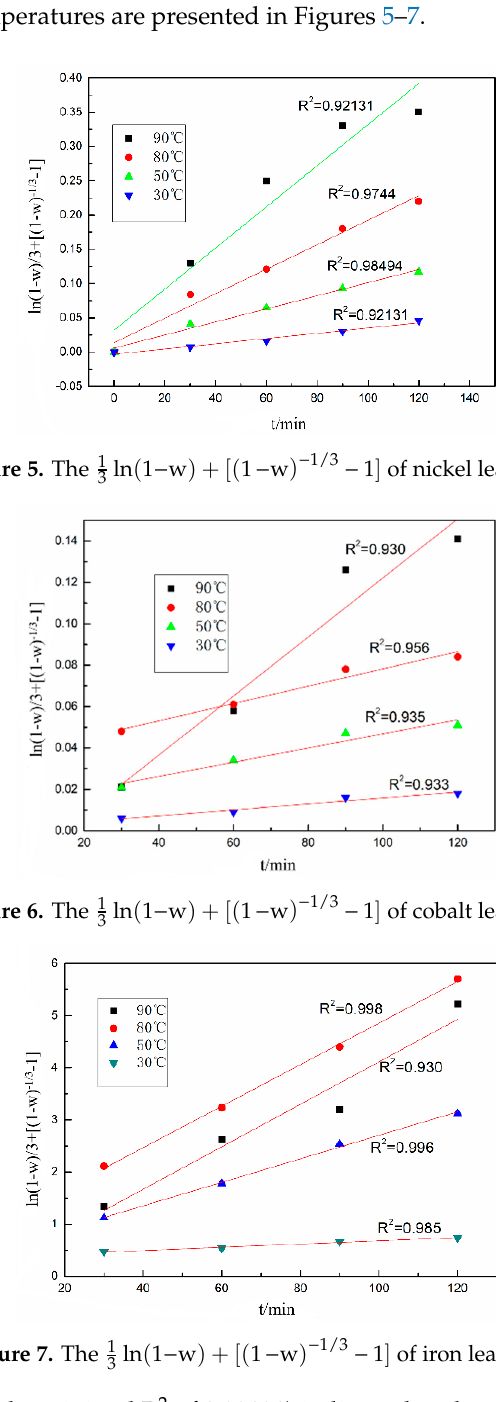
− 1/3 − Figure 7. The 1 ln ( 1 − w ) + [( 1 − w ) 1 ] of iron 3 Figure 7. The of iron leaching. 31 Figure 7. The ]1w)-1[()w-1(ln of iron leaching. Figure 7. The of iron leaching.